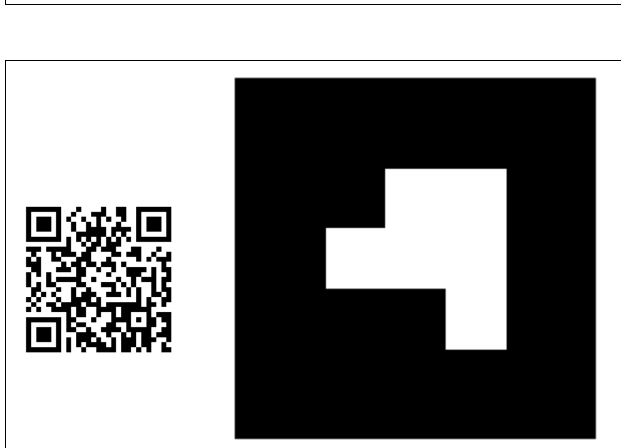
FIGURE 7 | QR code and Augmented Reality (AR) marker showing 3D comparison between the upper teeth morphologies of C. etruscus from Upper Valdarno (blue), Canis from Dmanisi (red), and extant C. lupus (grayish). Instructions: Scan the QR code on the left; open the link; allow the browser to access the camera of your device; point the camera toward the marker (on the right); and wait for the model to load (up to 10 seconds). It is possible to turn the device around the marker (or to move the marker) to see different parts of the model. Best visualization performances can be achieved by printing the markers, rather pointing at them on screens. Refer to Supplementary Material for common